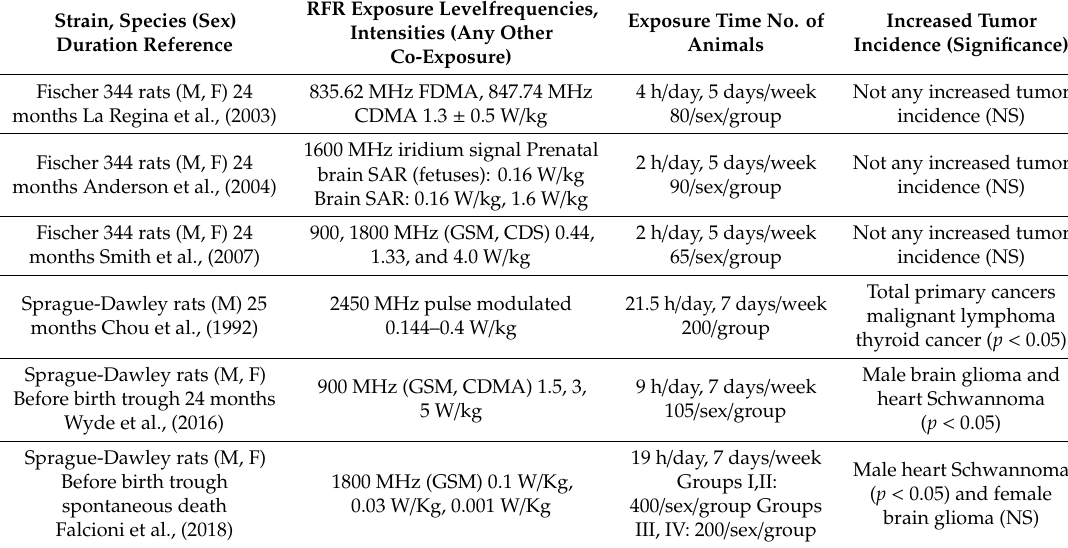
Table 1. Studies of carcinogenicity in rats exposed at least two years to radiofrequency radiation (RFR). RFR Exposure Levelfrequencies, Strain, Species (Sex) Exposure Time No. of Intensities (Any Other Duration Reference Co-Exposure)